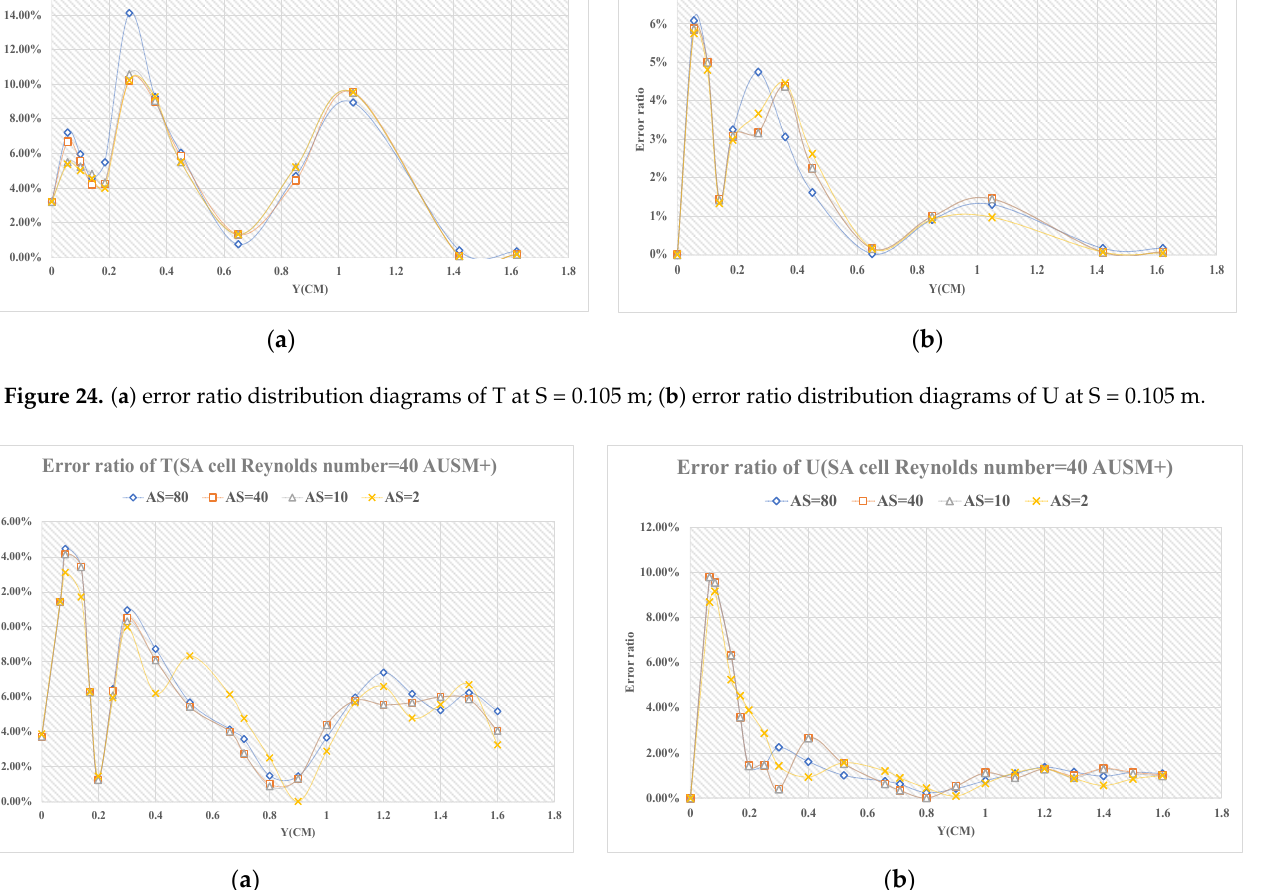
Figure 22. ( a ) ratio distribution diagrams between T and TINF at S = 0.155 m; ( b ) ratio distribution diagrams between U